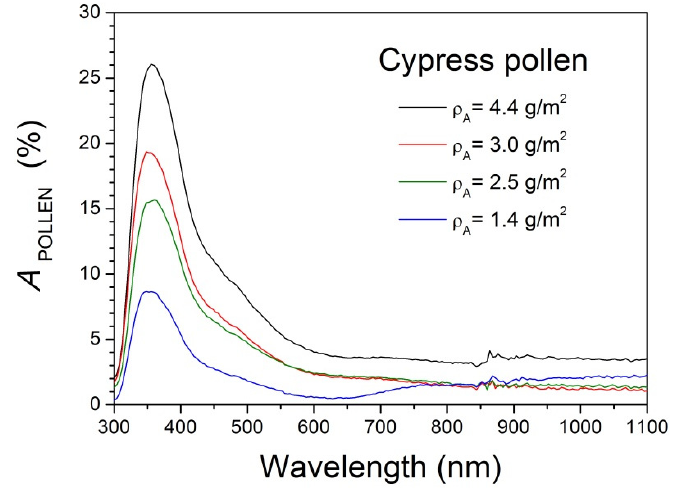
Figure 11. Absorbance spectra of cypress pollen ( A POLLEN ) as a function of the pollen mass density ( ρ A